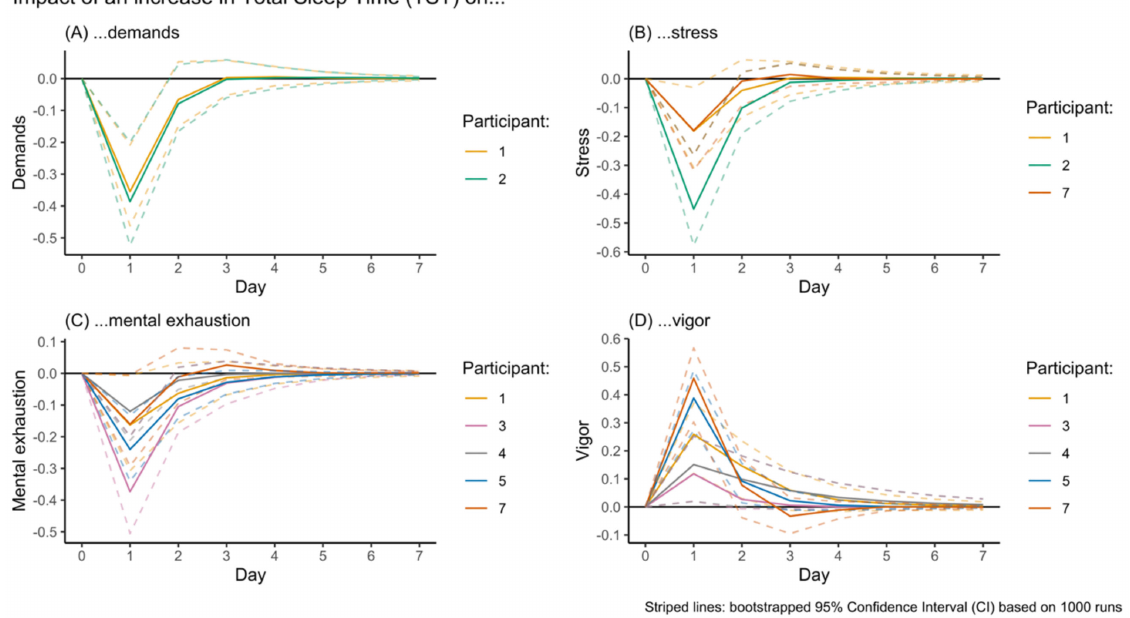
Figure 2. Visualization of the Impulse Response Function (IRF) of the impact of an increase in Total Sleep Time (TST) on the subsequent week’s demands, stress, mental exhaustion, and